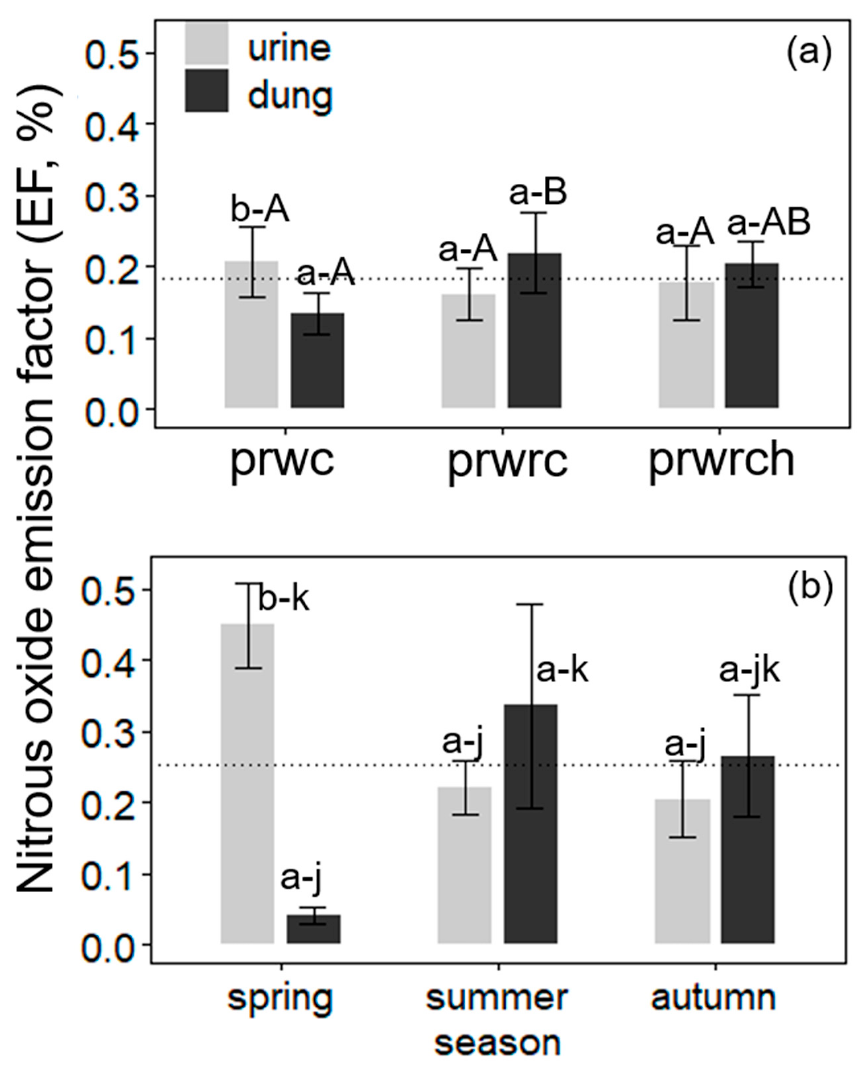
Figure 6. Bar charts showing N 2 O-N EF (% of applied excreta N emitted as N 2 O-N) as affected by ( a ) the grassland-treatment interaction effect in non-irrigated pastures and ( b ) season-treatment interaction effect in irrigated pastures. Means with different letters are significantly different [ p < 0.05; ABC being the grassland effect, jkl being the seasonal effect, and abc being the treatment effect].